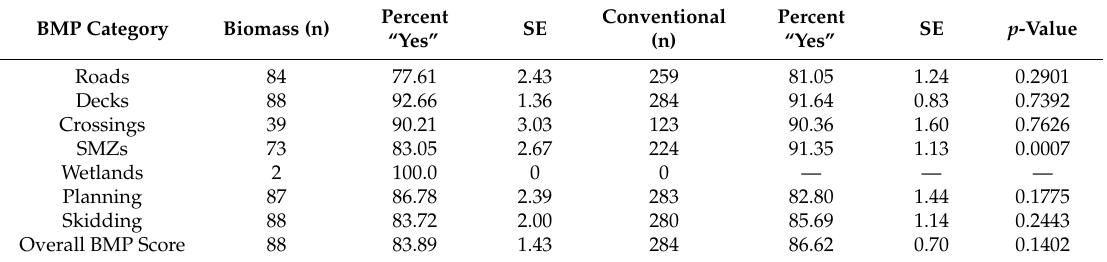
Table 2. Best Management Practice (BMP) audit scores by category for biomass ( n = 88) versus conventional ( n = 284) harvests over a three-year period (2010–2012) in the Piedmont of